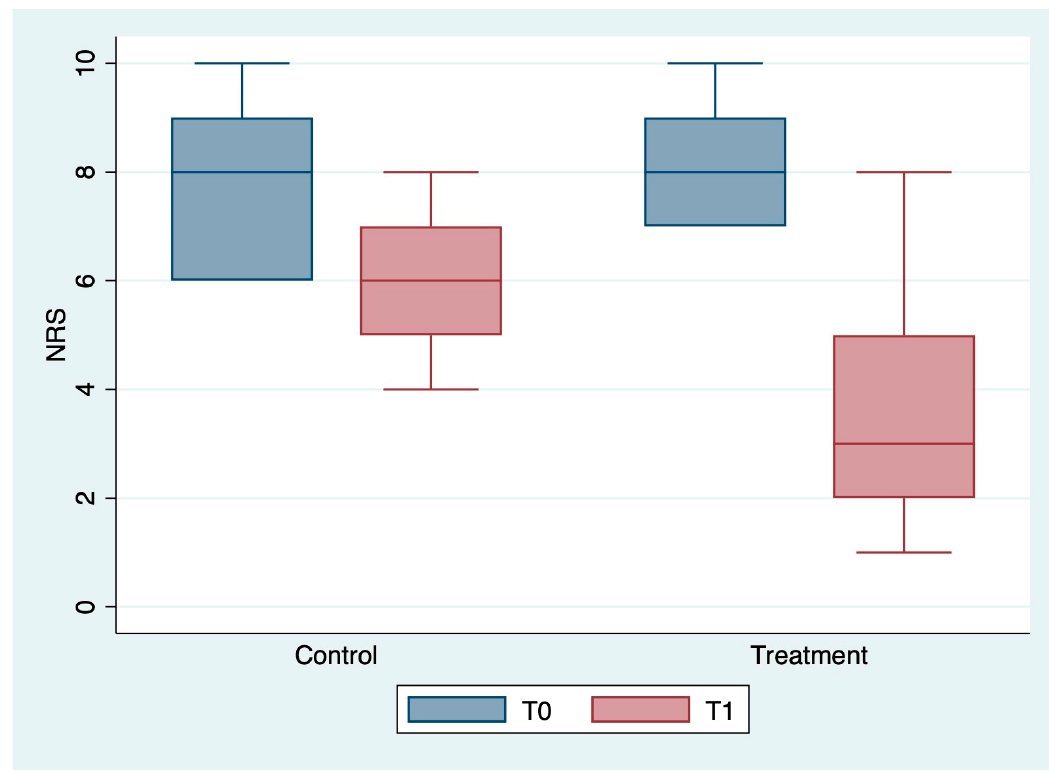
Medicina 2023 , 59 , x FOR PEER REVIEW Figure 1. Box plot of NRS values by detection time and group. Figure 1. Box plot of NRS values by detection time and group.